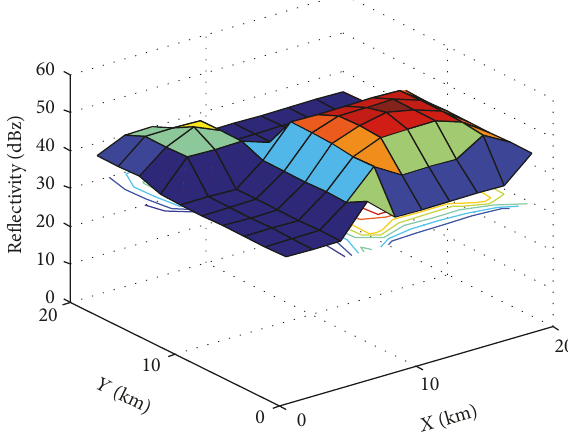
Figure 6: Initial field of radar reflectivity factor in the simulated area.